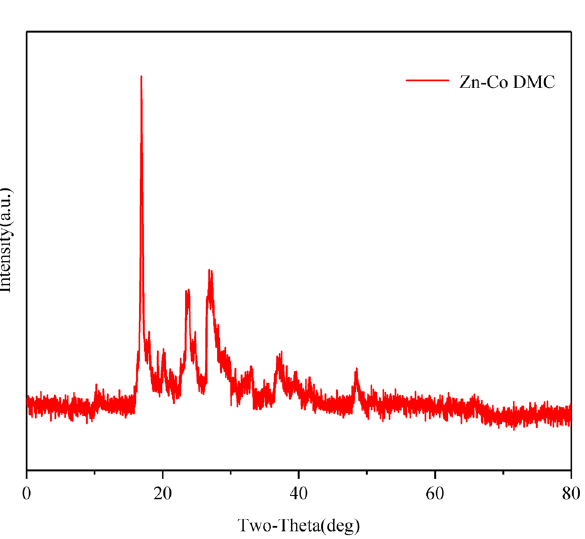
Figure A2: XRD pattern of the Zn – Co DMC complex catalyst.